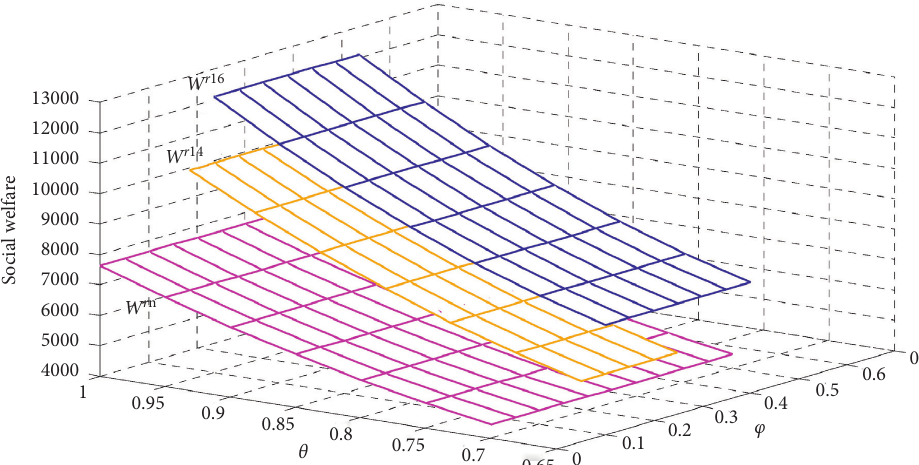
Figure 8: Social welfare under linkage price cap